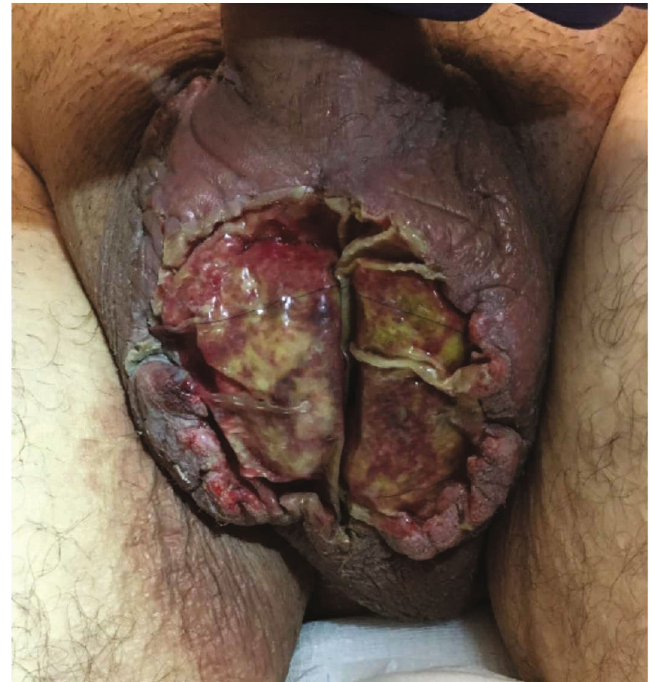
Figure 2: POD 3 after wound vac was removed. Integra graft seen to have taken